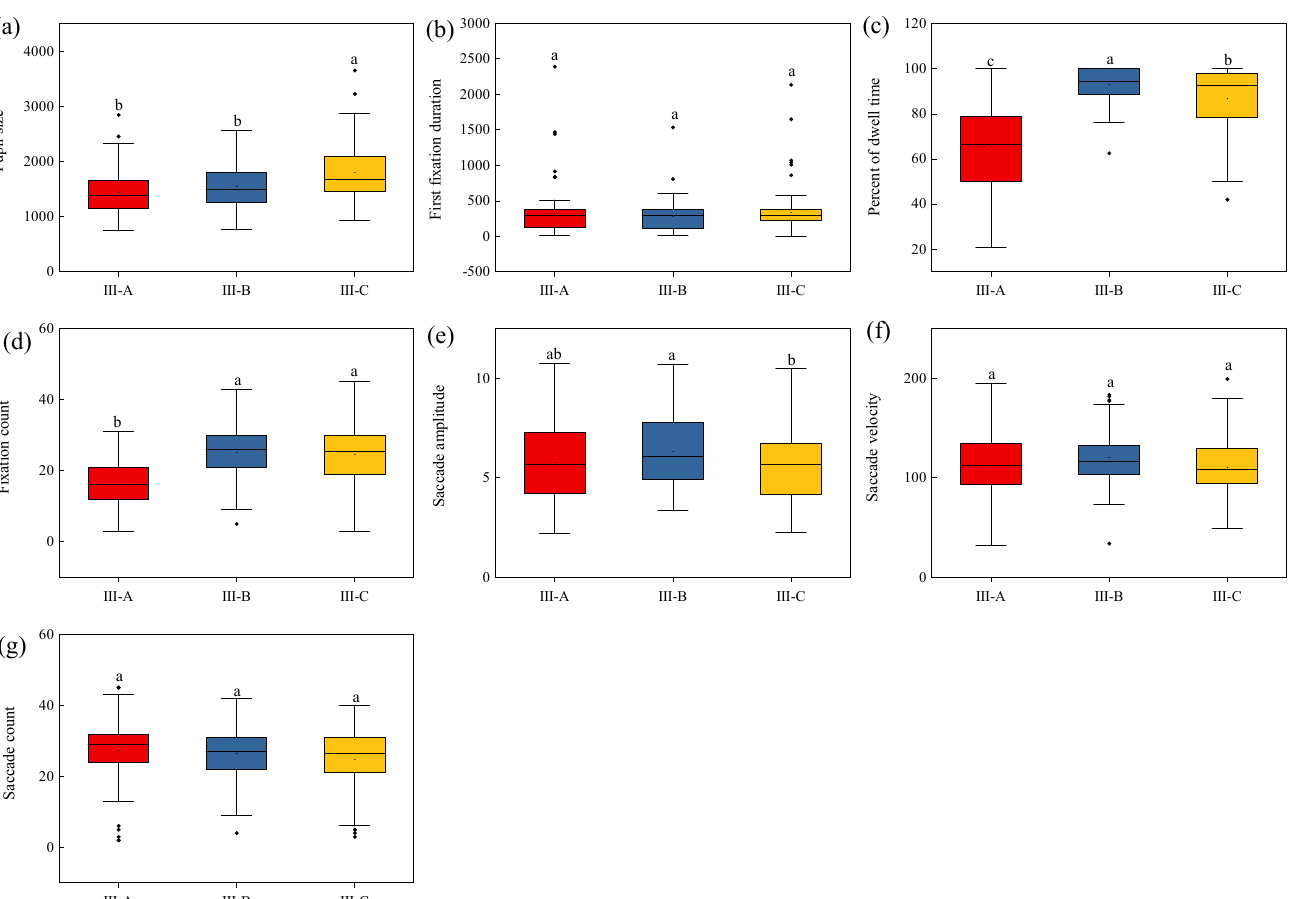
Figure 5. Eye-tracking measures of leaf color are shown, ( a – g ) represent pupil size, first fixation duration, the percentage of dwell time, fixation count, saccade amplitude, saccade velocity, and saccade count, respectively; III-A–III-C represent green, yellow, and red leaves, respectively. Different lowercase letters indicate significant differences among different attributes with the same category ( p < 0.05). Little square represents the mean and rhombus filled with black represents outliers.